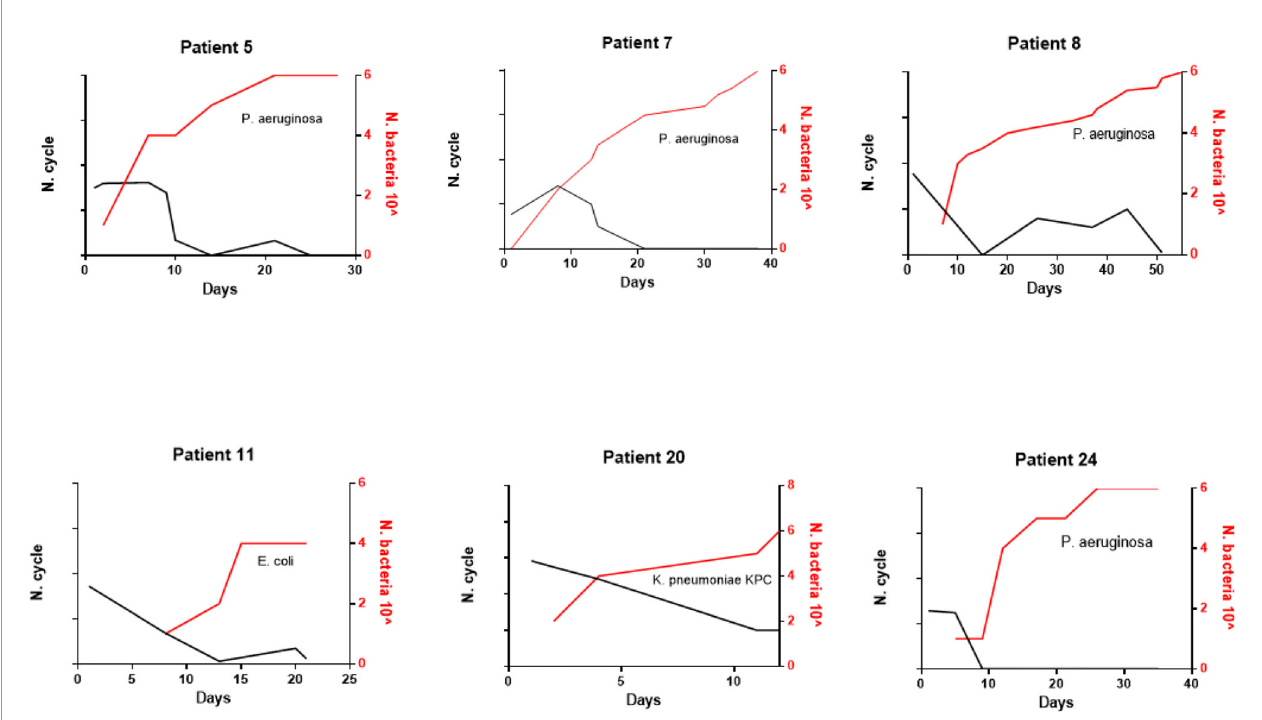
FIGURE 2 | Evolution of SARS-CoV-2 c/t detection (black line) and bacteria load (red line) over the time of hospitalization in six representative